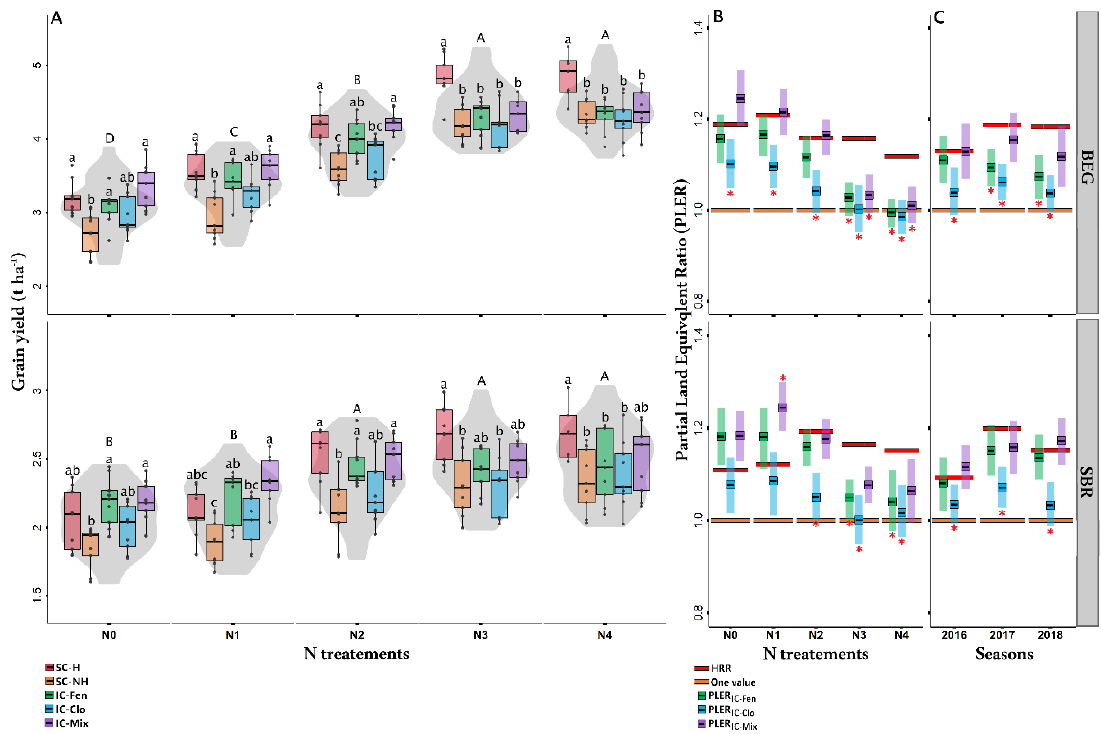
Figure 2. Durum wheat grain yield and PLER at both sites. ( A ) Grain yield affected by N treatment (Violin plot) and cropping pattern within each N treatment (Box plot) averaged over the three seasons; Violin plots headed by a common capital letter are not significantly different at p < 0.05 according to Tukey’s HSD-test. Within each violin plot, box plots with a common lowercase letter are not significantly different at p < 0.05 according to Tukey’s HSD-test (for statistical output see Table S3). ( B ): PLER of the three intercropping patterns compared to the herbicide response ratio (HRR) in each N treatment averaged over the three seasons; ( C ): PLER of the three intercropping patterns compared to the herbicide response ratio (HRR) in each season averaged over the five N treatments; In ( B , C ) panels, PLER: partial land equivalent ratio - yield in intercrop divided by yield in sole crop with no herbicide; HRR: herbicide response ratio - yield in sole crop with herbicide divided by yield in sole crop with no herbicide; Orange lines indicate a relative yield of one, i.e., with yield equal to that of a sole durum wheat with no herbicide; Red lines indicate the HRR; Tiles represent the means PLER and 95% confidence intervals of each intercropping pattern; Top asterisk (*) indicates a significant increase and bottom asterisk indicates a significant decrease compared to the HRR (Tukey - test, α = 0.05).